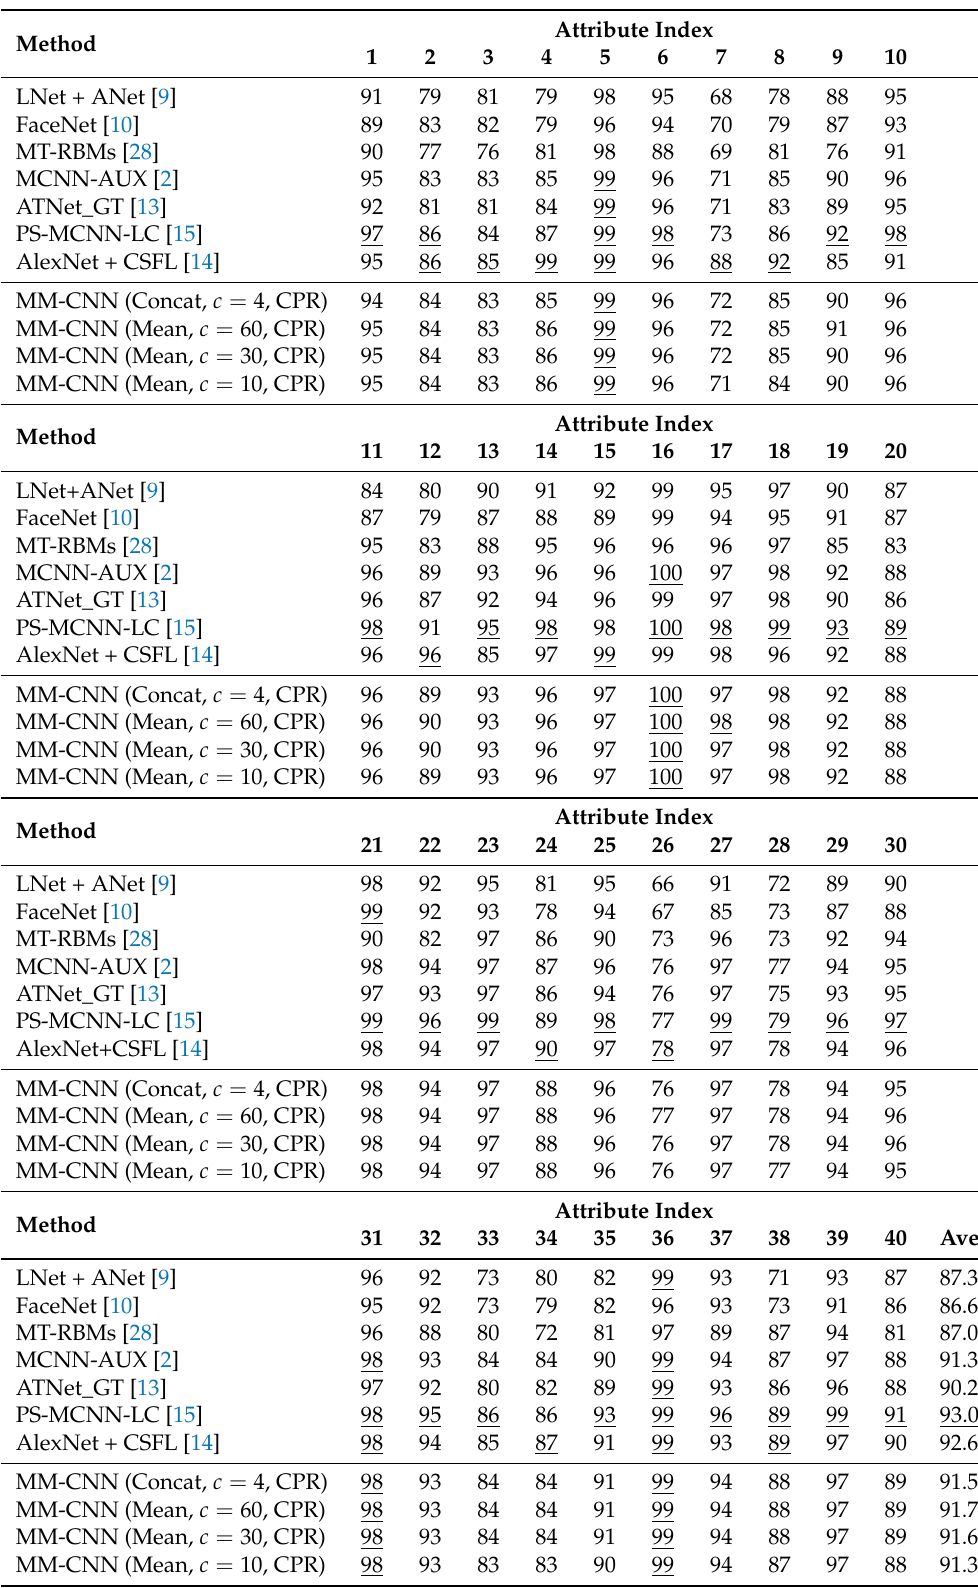
Table 8. Estimation accuracy of face attribute estimation methods for CelebA. Best accuracy is shown with